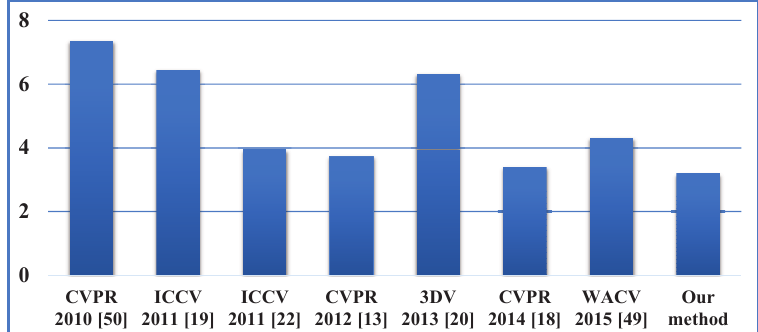
Figure 20. Comparative analysis of the joint estimation error